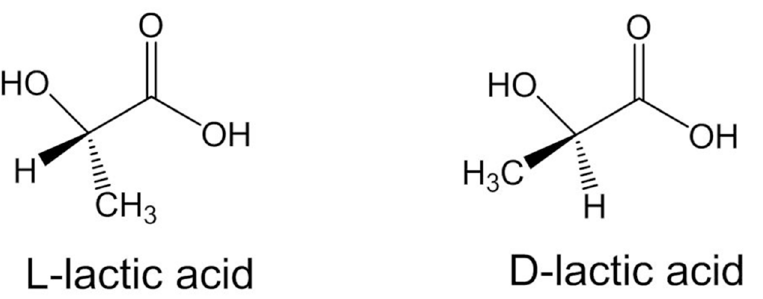
Figure 4. Enantiomeric structures of poly-lactic acid monomer. Polymers containing exclusively either (L)-lactic acid (PLLA) or (D)-lactic acid (PDLA) are semi-crystalline with a glass transition temperature (Tg) of about 60 °C and a melting temperature (Tm) of 175 °C. Semi-crystalline PLA has a Young's modulus of between 3 and 3.5 GPa, a tensile strength of between 50 and 70 MPa.